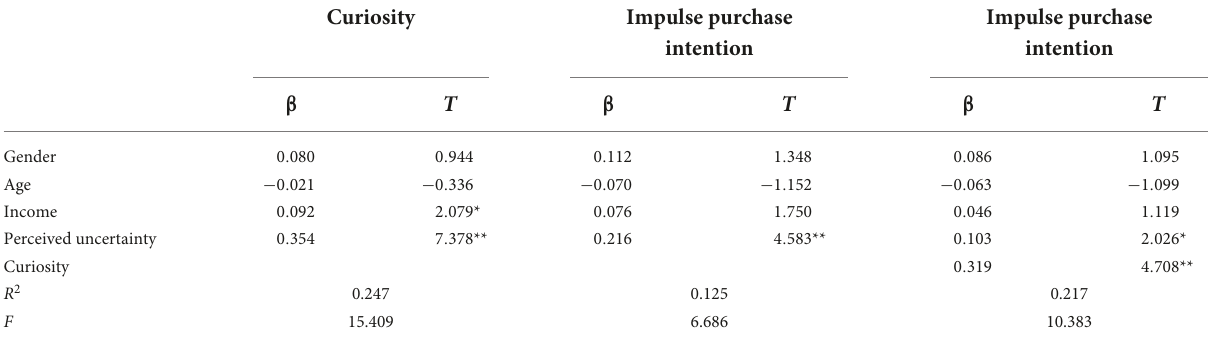
TABLE 5 Curiosity as a test of the mediating model.